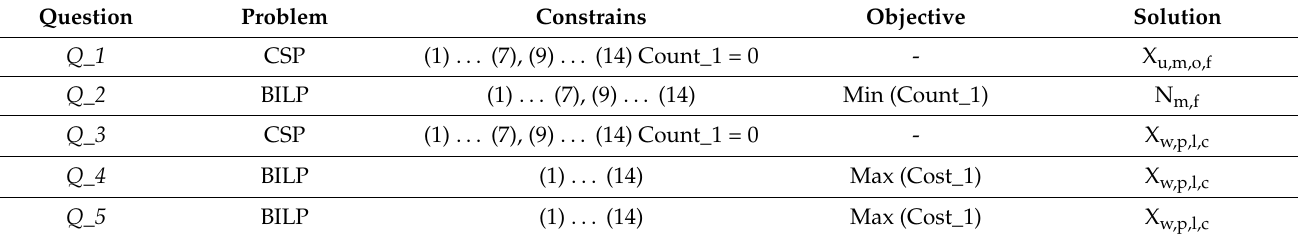
Table 4. Question modelling